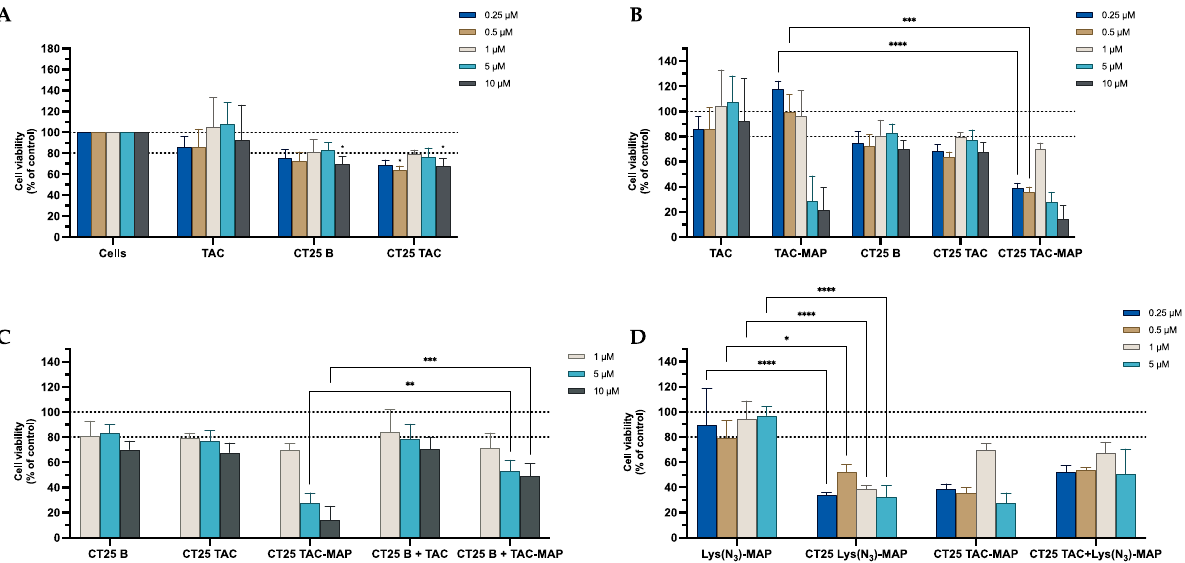
Figure 15. Relative cell viability of SH-SY5Y cell line measured by the MTT reduction after 24 h incubation. ( A ) represents NLC safety test with the treatment of free TAC, blank CT25, and TAC-loaded CT25 (0.25–10 µ M). ( B ) Represents differences in the cell viability of treatment with free TAC, TAC-MAP, blank CT25, TAC-loaded CT25, MAP, TAC-MAP-loaded CT25 (0.25–10 µ M). ( C ) Represents co-administration of TAC and TAC-MAP with blank CT25 (1–10 µ M). ( D ) Represents the data obtained from the encapsulation of Lys(N 3 )-MAP and co-encapsulation of TAC and Lys(N 3 )-MAP in the NLC compared with peptide conjugate. Results are expressed as means ± SD (n = 4). Statistical analysis between the groups was performed using two-way ANOVA with Tukey’s multiple comparisons test (* p < 0.05; ** p < 0.01; *** p < 0.001; **** p < 0.0001).